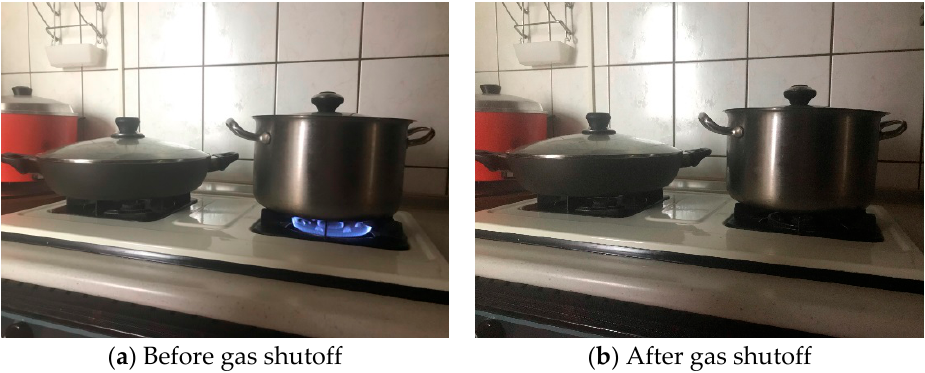
Figure 20. Interface for remotely turning off the gas supply.